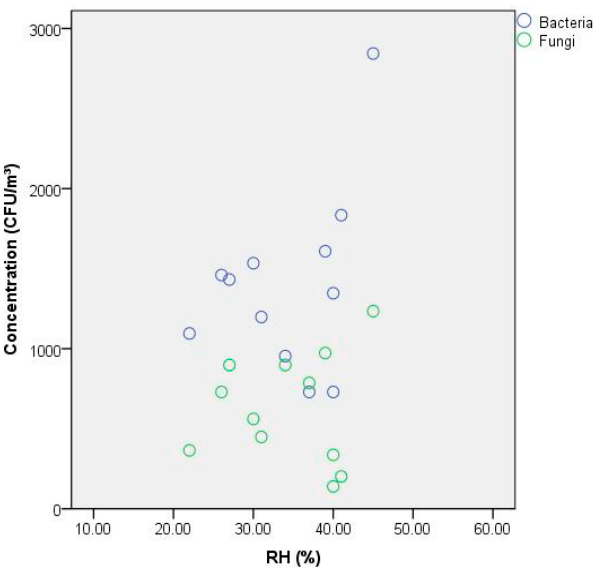
Figure 6. Correlations between the airborne microbe concentration and the RH (6 occupants, sam- pling time: 21:30–22:30). time: